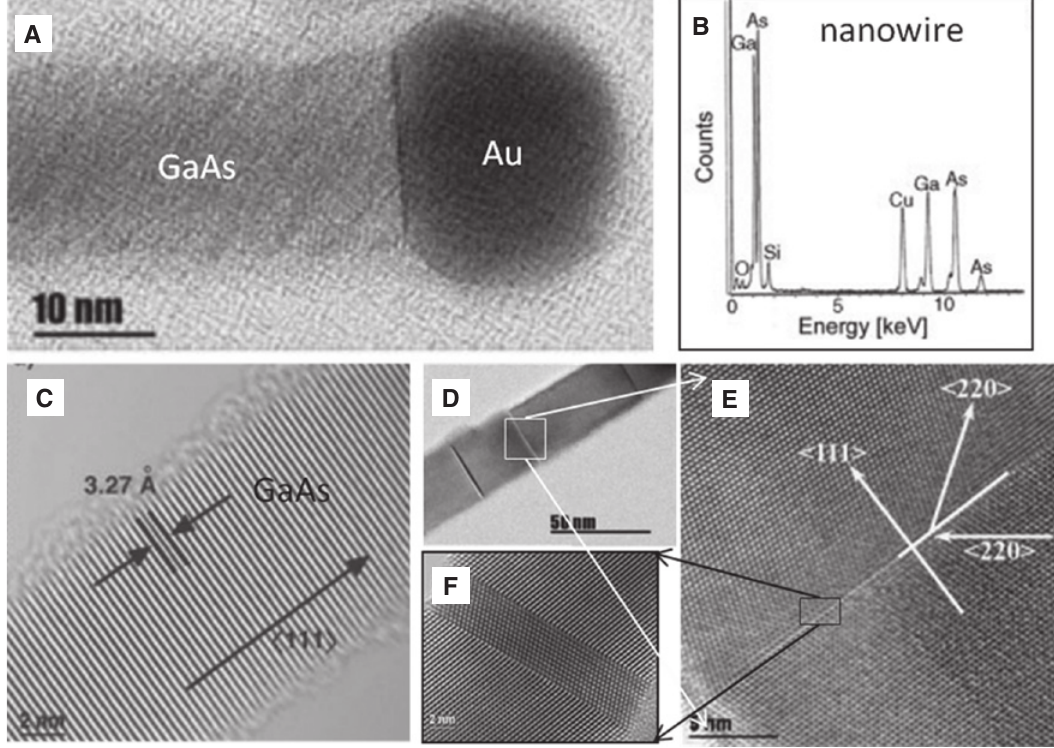
Figure 13: Seed-oriented NW growth via the SCF-liquid-solid route. (A) Thiol-capped Au seed nanocrystal for growing GaAs NWs; (B) XPS data of NWs, showing the presence of Si (from precursor) as doping atom in NW; (C) single crystal GaAs NW with diameter < 15 nm; (D) multitwinned GaAs NW with diameter > 15 nm; (E, F) high resolution of twinning faults. Reprinted with permission from Davidson III FM, Schrinker AD, Wiacek RJ, Korgel BA, Adv. Mater. 2004, 16, 646–649 [80], Copyright 2004 J.